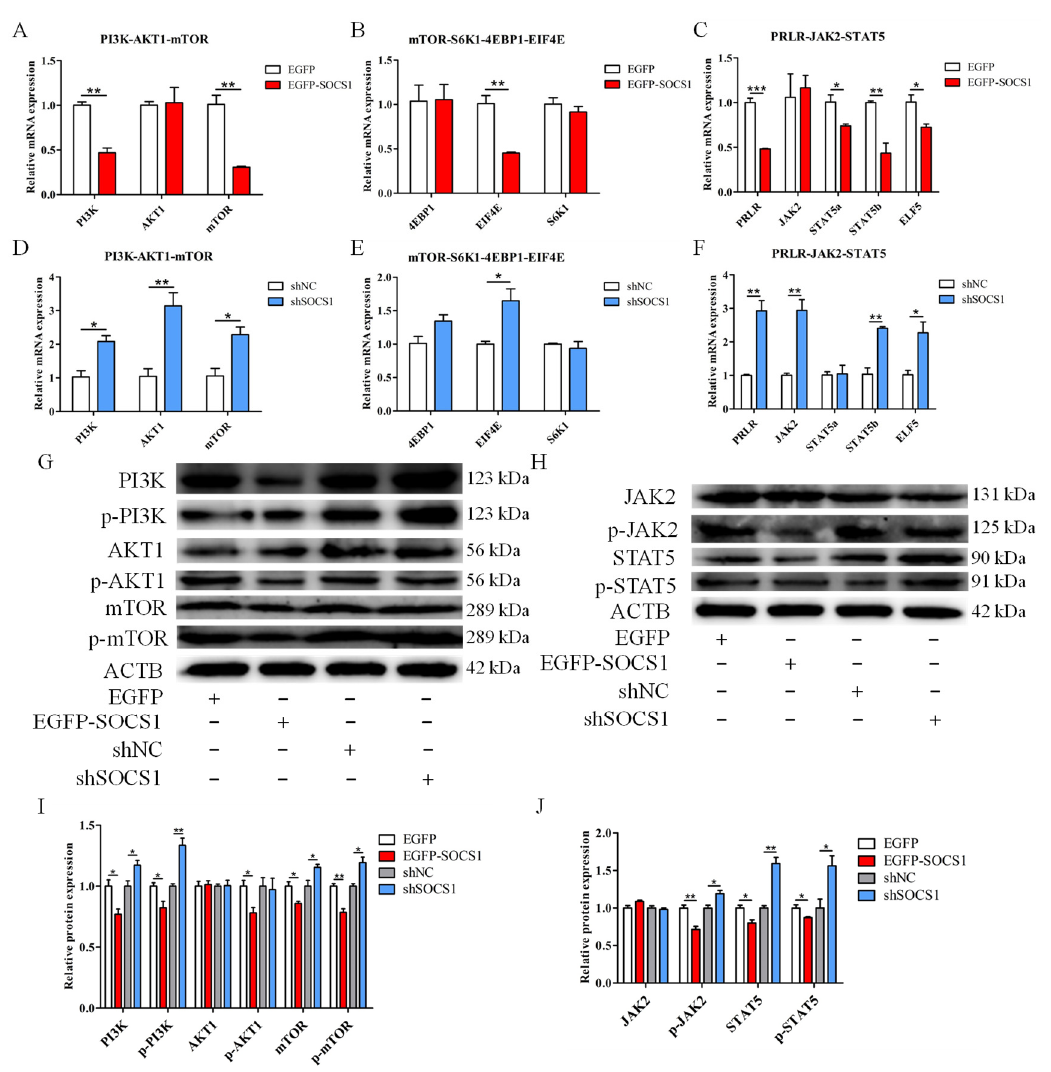
Figure 4. Effect of SOCS1 on the expression of genes and proteins related to the mTOR and JAK2-STAT5 pathways in BuMECs. ( A , D ) Effects of EGFP- SOCS1 or sh SOCS1 on the expression of genes related to the upstream pathway of mTOR signaling. ( B , E ) Effects of EGFP- SOCS1 or sh SOCS1 on the expression of genes related to the downstream pathway of mTOR signaling. ( C , F ) Effects of EGFP- SOCS1 or sh SOCS1 on the expression of genes participating in the JAK2-STAT5 signaling. ( G – J ) Effects of EGFP- SOCS1 or sh SOCS1 on the expression of proteins related to the mTOR and JAK2-STAT5 pathways. Data are presented as means ± SEM for three individual cultures; * p < 0.05, ** p < 0.01, *** p <